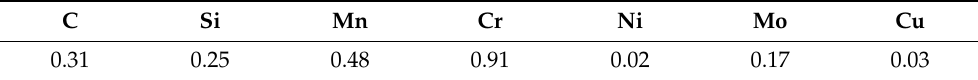
Table 1. Chemical composition of the 30CrMo steel